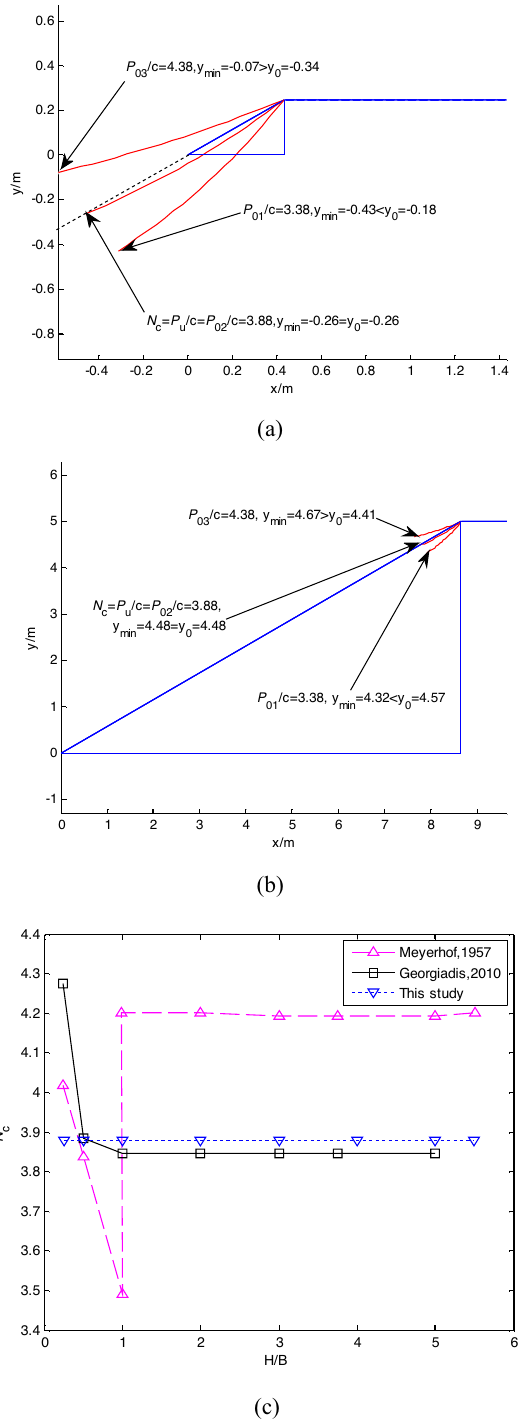
Figure 5. Influence H/B on N c with α = 30° and c/γB = 1: ( a ) H/B = 0.25; ( b ) H/B = 5; ( c ) comparison of N c